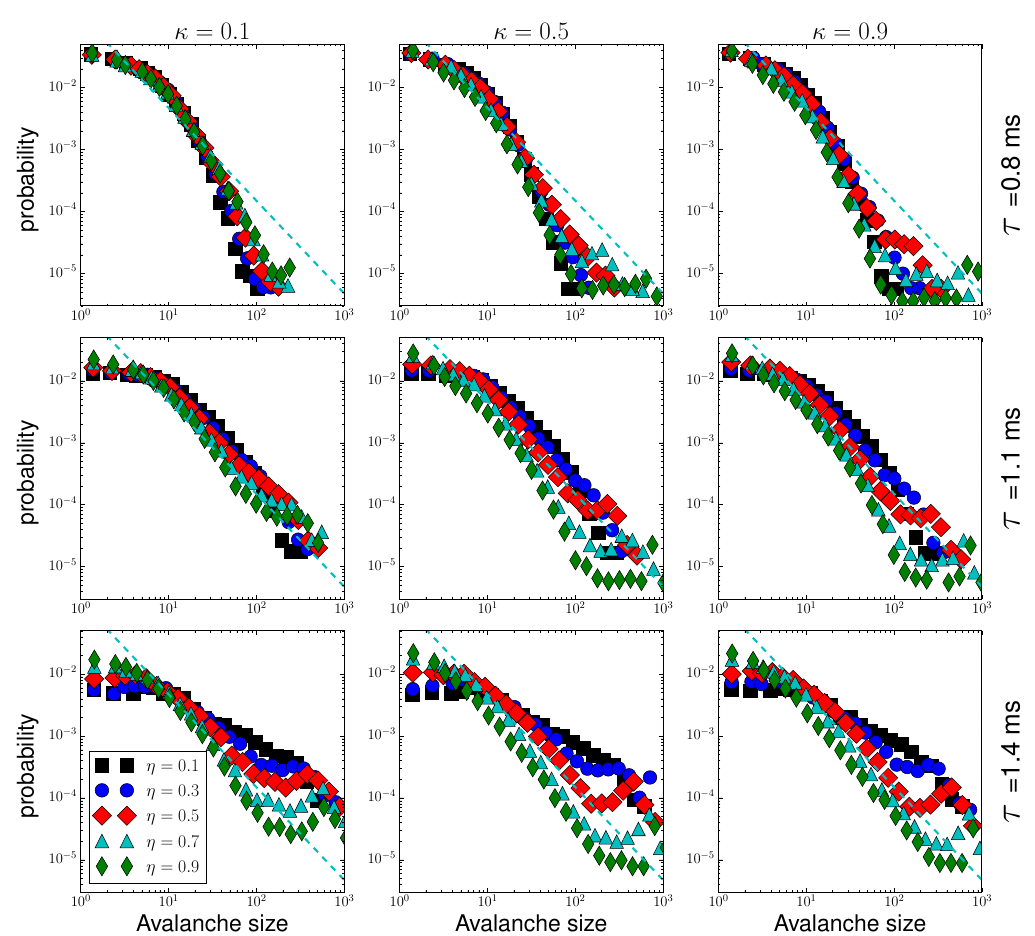
Figure 2. Probability distribution of avalanche sizes. We variate rich-club connectivity κ , synaptic time course τ , and excita- tion population η . The synaptic amplitude is w = 5 mV. top row: synaptic time course τ = 0.8 ms, middle row: τ = 1.1 ms, and down row: τ = 1.4 ms. Left column: κ = 0.1, middle column: κ = 0.5, and right column: κ = 0.9. Each function represents the result of 500 independent runs. As a guide for the eye, the dotted line indicates a power-law function with α = − 1.5.